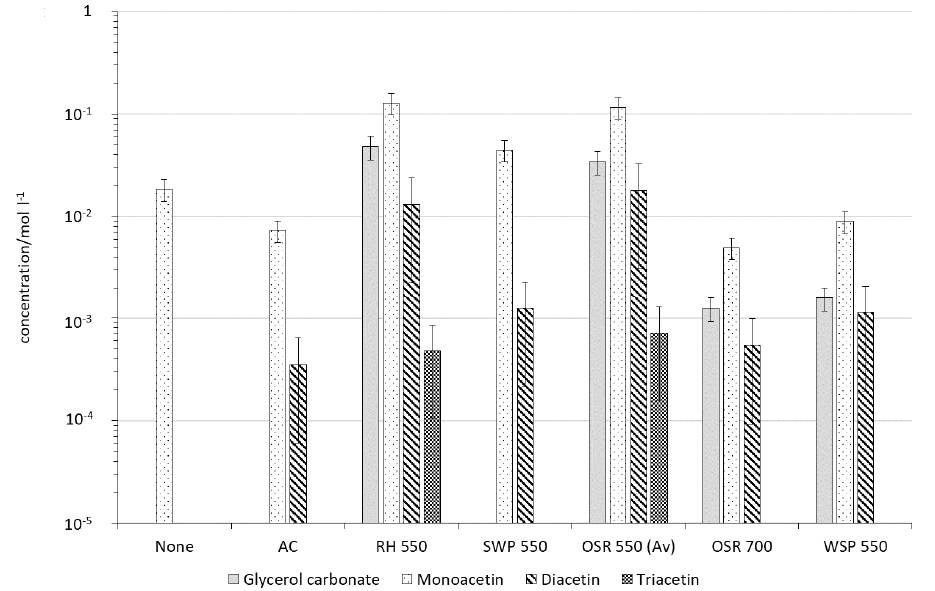
Figure 6. Concentration of liquid phase products (glycerol carbonate, monaocetin, diacetin and triacetin) for carbonaceous materials from four di ff erent biochar feedstocks (rice husk (RH), soft wood (SWP), oil seed rape (OSR) and wheat straw (WSP)). These are compared with a commercial activated charcoal (AC) and no catalyst. Error bars are percentage error, estimated from three repeats of OSR 550 (average denoted by (Av)). A logarithmic y -axis is used to present high and low concentration